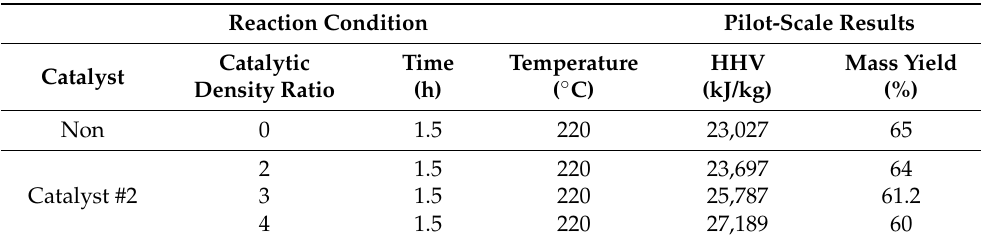
Table 7. Comparison of calorific value and mass yield after catalytic HTC of waste wood according to catalytic density ratio at the pilot